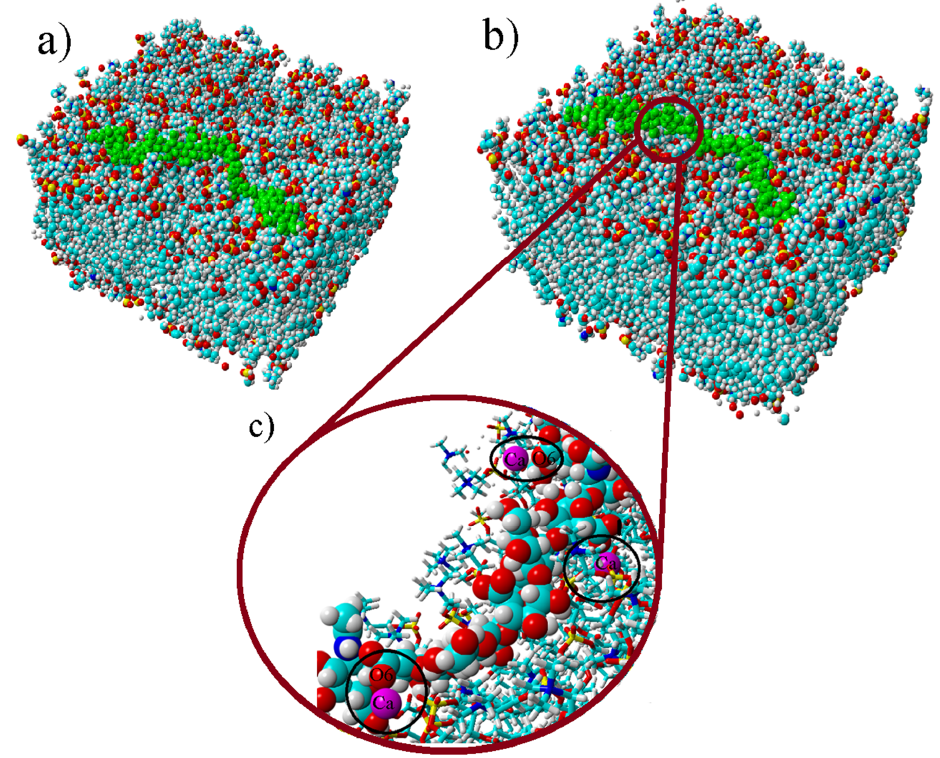
Figure 7. Snapshot from the simulation box: ( a ) initial position, ( b ) final structure. Green polymer represents HA. DPPC lipids are colored in the following way: hydrogen (white), carbon (turquoise), oxygen (red), nitrogen (blue) and phosphorus (yellow). ( c ) Enlarged snapshot from the simulation box at the final state. Phospholipids are represented in line connected structure, HA and Ca 2+ as beads. In the picture we see simulation results in the presence of CaCl 2 at 37 °C, and some calcium ions are found within the black circles in panel C.